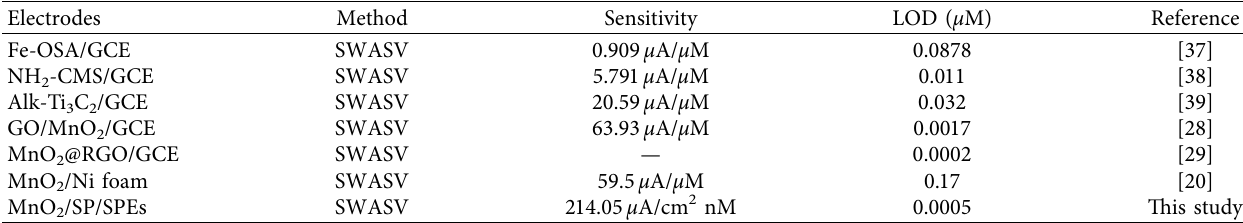
Table 1: Comparison of the MnO